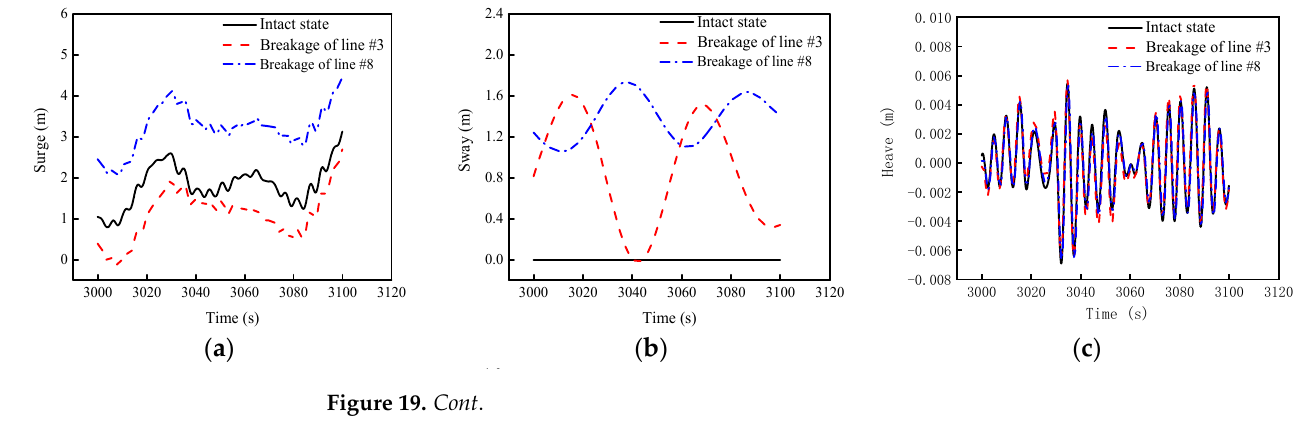
Breakage of line #8